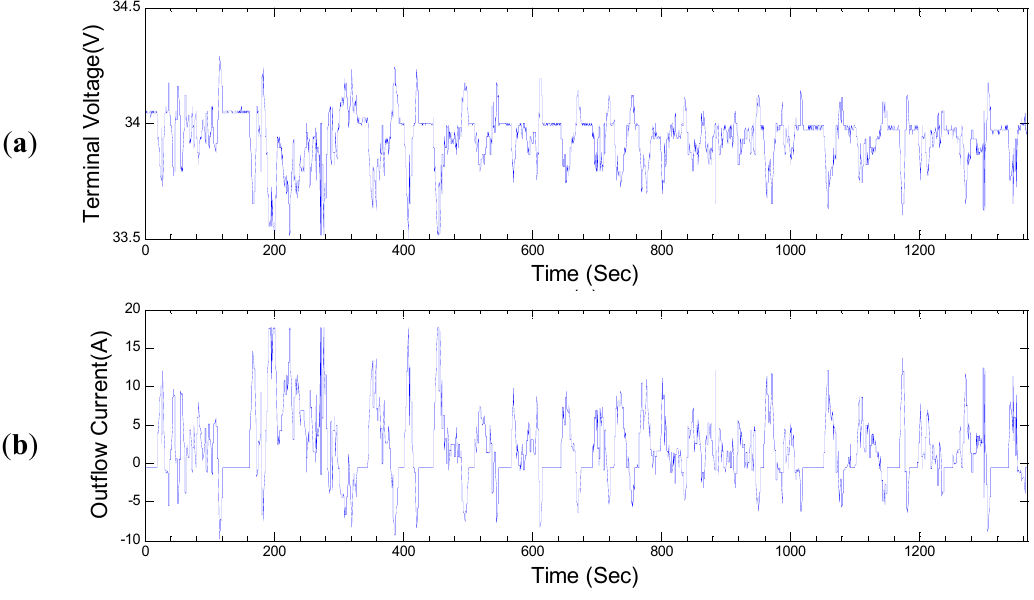
Figure 7. Measured input–output data in a FUDS cycle: ( a ) Terminal voltage; ( b )